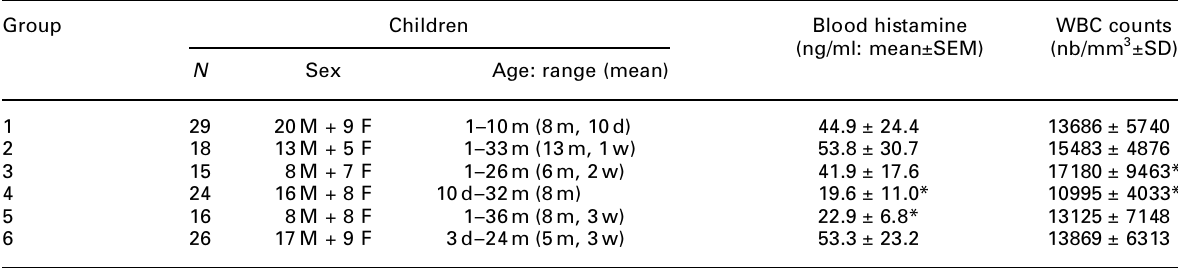
Table 1. Characteristics of the infants and children, and results of blood histamine determinations and white blood cell counts Group